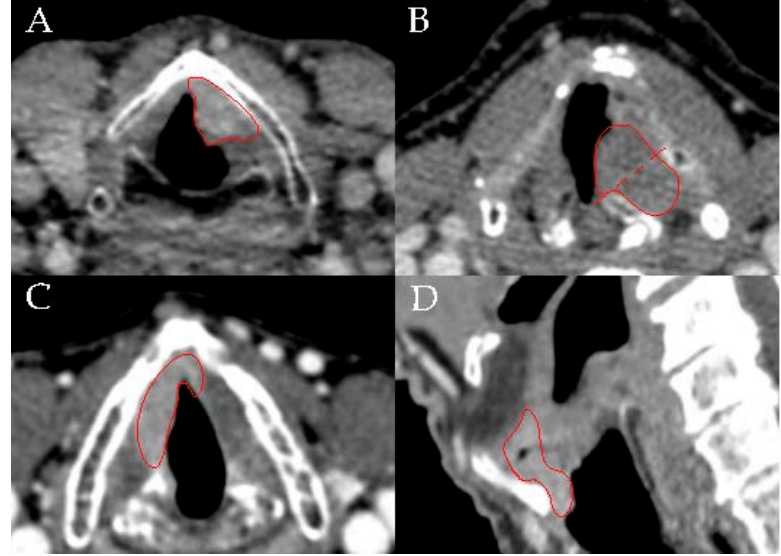
Figure 1. Examples of the four parameters scored in Computed Tomography and Magnetic Resonance Imaging scans.: ( A ) deep infiltration of left glottic in the vocal fold muscle; ( B ) tumor that is located both anterior and posterior of the M-line; ( C ) horizontal involvement of the anterior commissure in the glottic plane; ( D ) vertical involvement of the anterior commissure (supraglottic and infraglottic